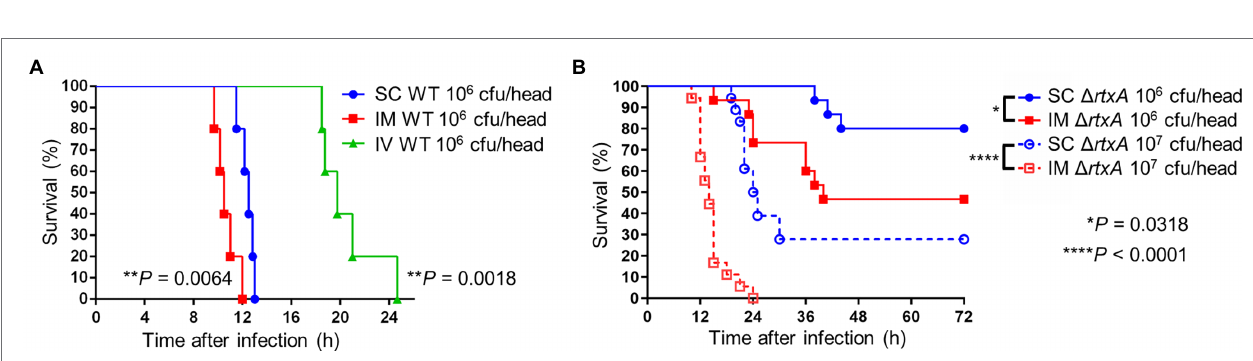
FIGURE 7 | Critical invasion leading fatal outcome. (A) Kaplan–Meier survival curves for mice ( n = 6/group) inoculated subcutaneously (SC), intramuscularly (IM), or intravenously (IV) with CMCP6 wild type (WT) and monitored for 72 h. ** p < 0.01 compared with SC inoculation; log-rank test. (B) Kaplan–Meier survival curves for mice ( n = 12/group) inoculated SC or IM with CMCP6 Δ rtxA (10 6 CFU/mouse and 10 7 CFU/mouse) and monitored for 72 h. **** p < 0.0001, * p < 0.05 compared with each dose of SC inoculation; log-rank